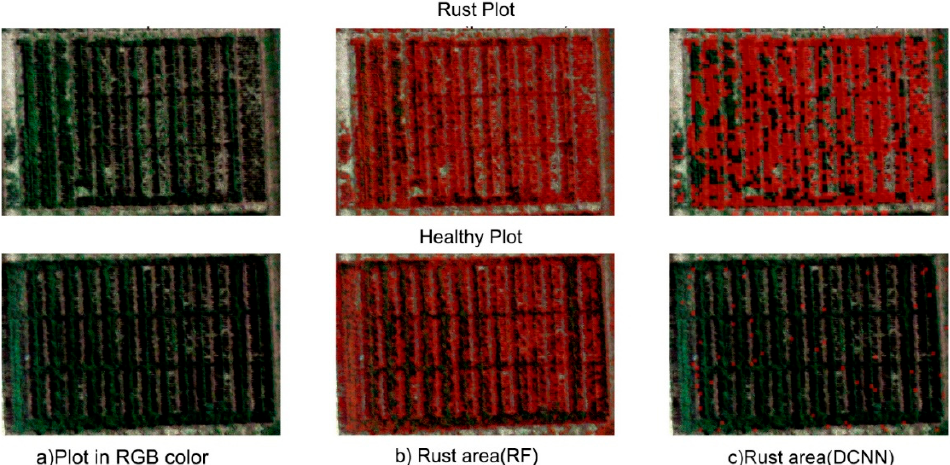
Figure 11. The rust detection mapping results of two plots from the random forest (RF) model and the proposed DCNN method: ( a ) original images of rust and healthy wheat plots in RGB colour; ( b ) the rust detection results of random forest model overlaid on original images; ( c ) the rust detection results of the DCNN model overlaid on the original images. The label in red colour denotes the detection results of rust infected areas.